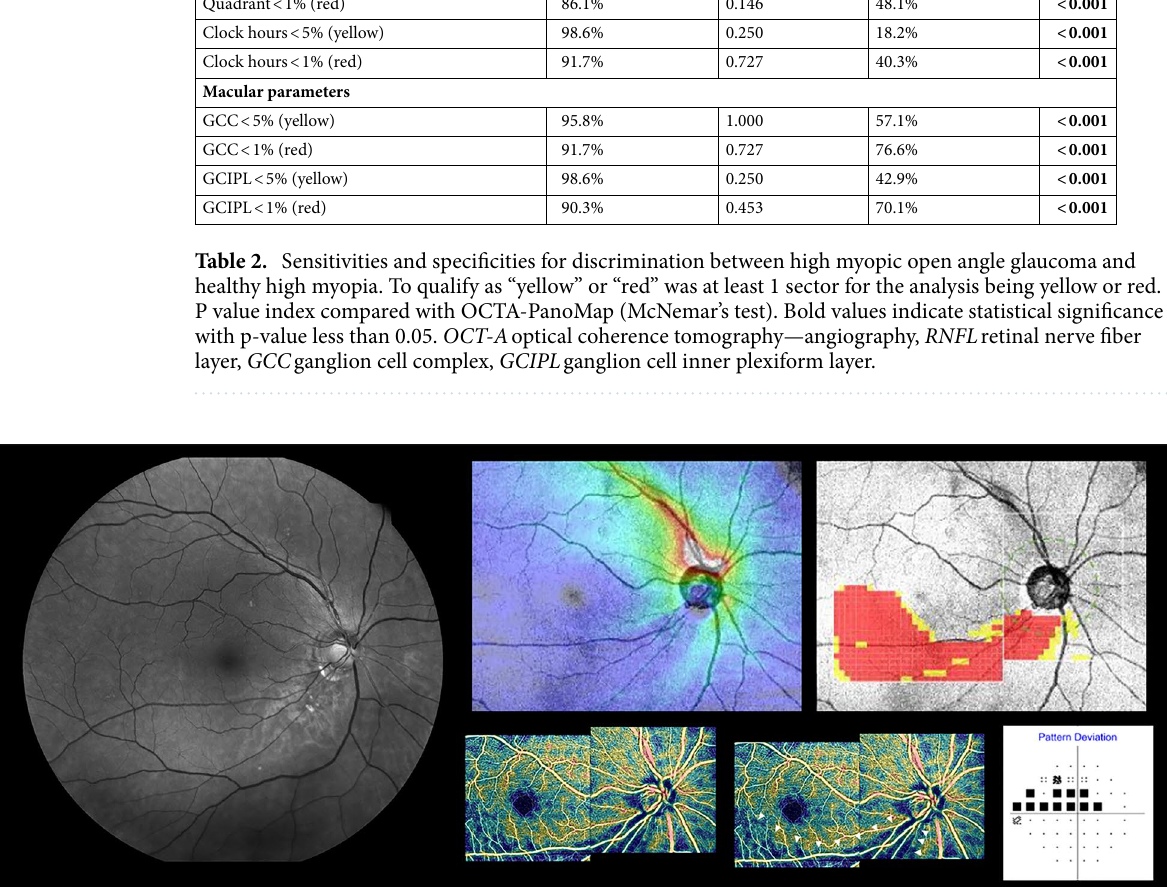
Figure 1. Representative case of the wide-field OCTA density map (OCTA-PanoMap) in high myopic glaucoma. Right eye of a 65-year-old female with high myopic open-angle glaucoma (axial length 27.04 mm, spherical equivalent -8.125 D). Inferotemporal RNFL defect, which is not clearly visible in red-free fundus photography is well visualized in wide-field SS-OCT thickness map, deviation map, and OCTA-PanoMap (white arrow head). Superior scotoma is confirmed using visual field tests. OCTA optical coherence tomography angiography, RNFL retinal nerve fiber layer, SS-OCT swept-source